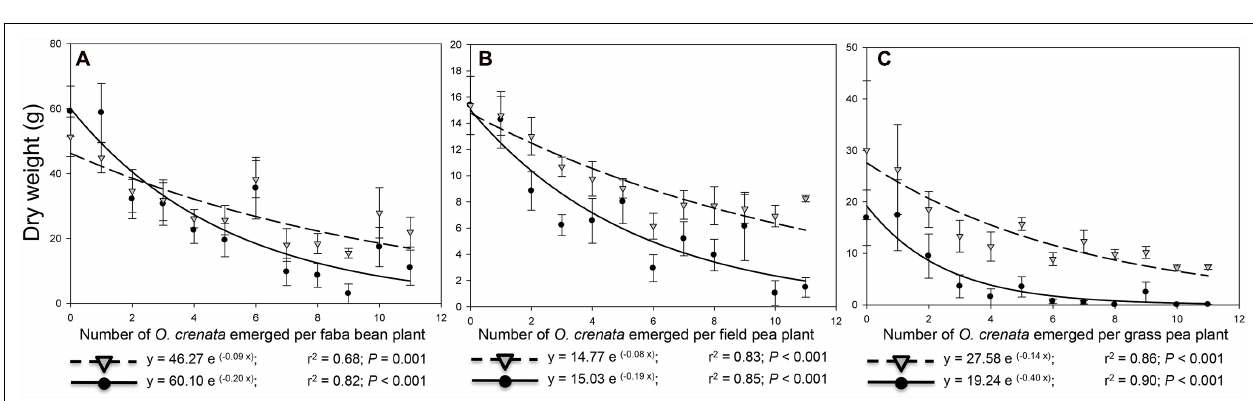
FIGURE 2 | Relationship between total dry weight and infection severity measured as O. crenata emergence per host plant. Host vegetative dry matter (leaves and stems; (cid:79) ), Host reproductive dry matter (host